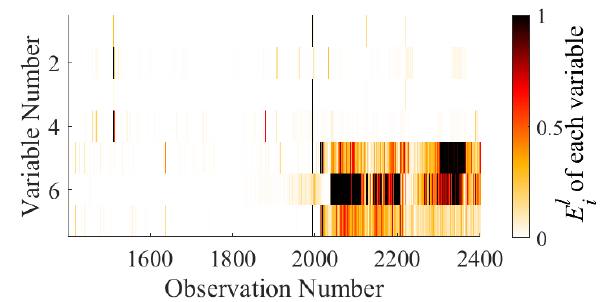
Figure 8. The sample by sample normalized GRU residuals in Case 1.